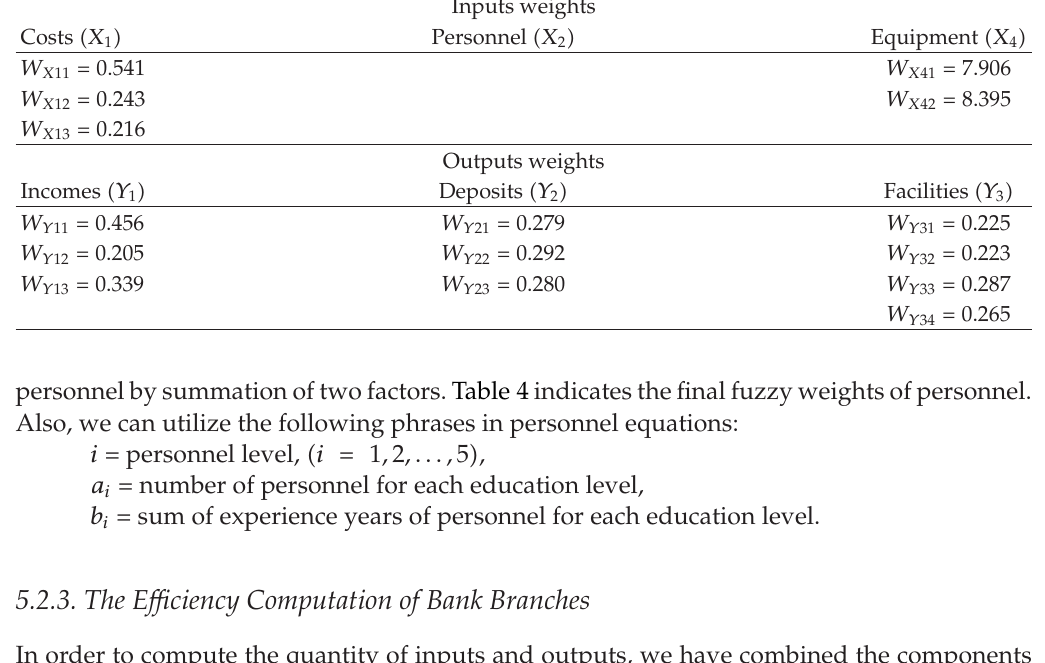
Table 3: Final fuzzy weights of inputs and outputs. Inputs